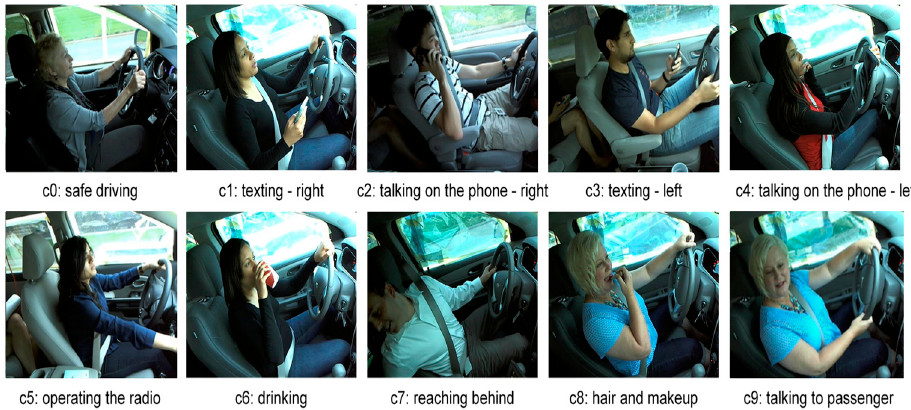
Figure 10. State Farm Distracted Driver dataset class representation [48].